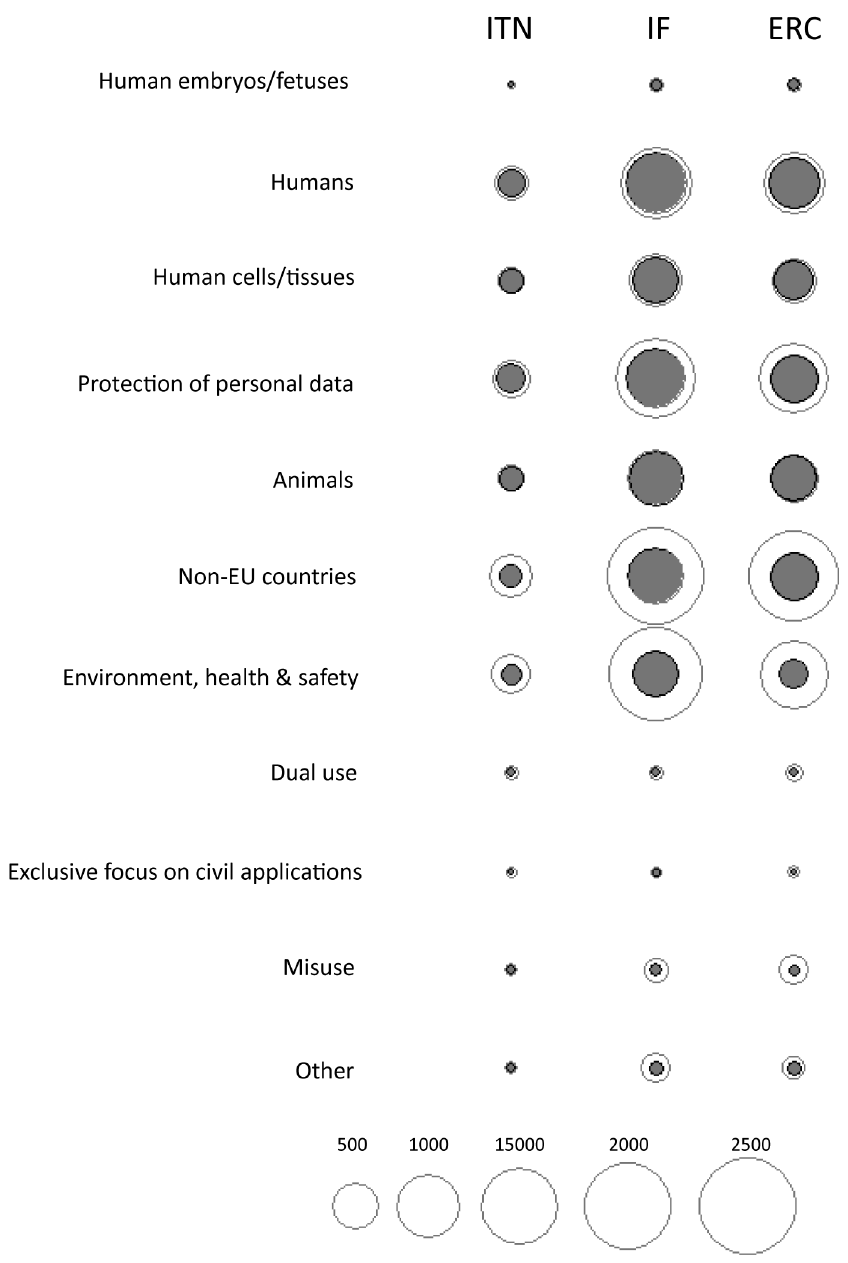
Figure 6. Comparison between ethics issues identified by proposal applicants (grey) and ethics experts (white), by ethics categories. ITN – Innovative Training Networks, IF – Individual Fellowships, ERC – European Research Council grants. The data are from years available in the SEP tool of the European